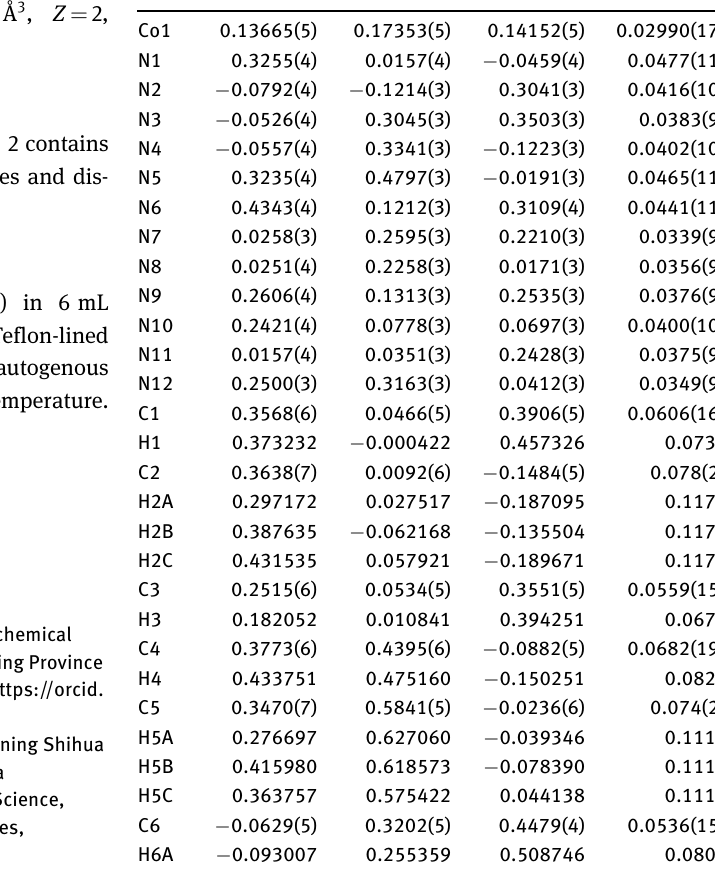
Table 1 contains crystallographic data and Table 2 contains the list of the atoms including atomic coordinates and dis- placement parameters.